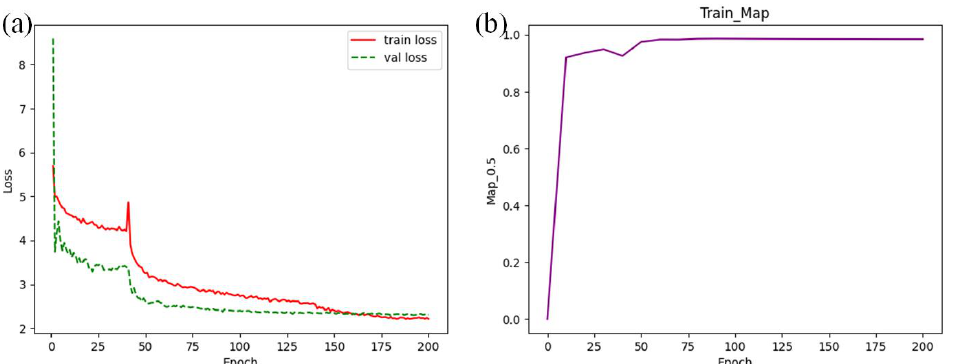
Figure 8. Variation of parameters during network training: ( a ) loss changes; ( b ) object detection